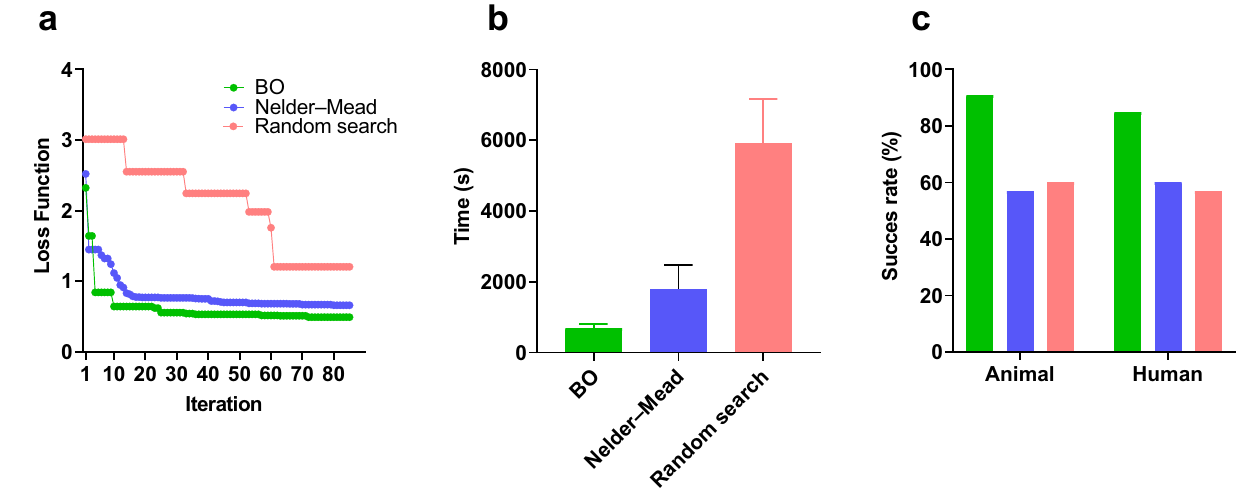
Figure 5. Performance comparison in three optimisation methods: Bayesian optimisation (BO), Nelder–Mead and random search. Panel ( a ) shows the loss function of three methods analysed in one data set. Panel ( b ) shows the mean and variance of the time consumptions of three techniques in three random data. Panel ( c ) shows the success rate (the percentage of optimisation solutions in total) of each method in three data